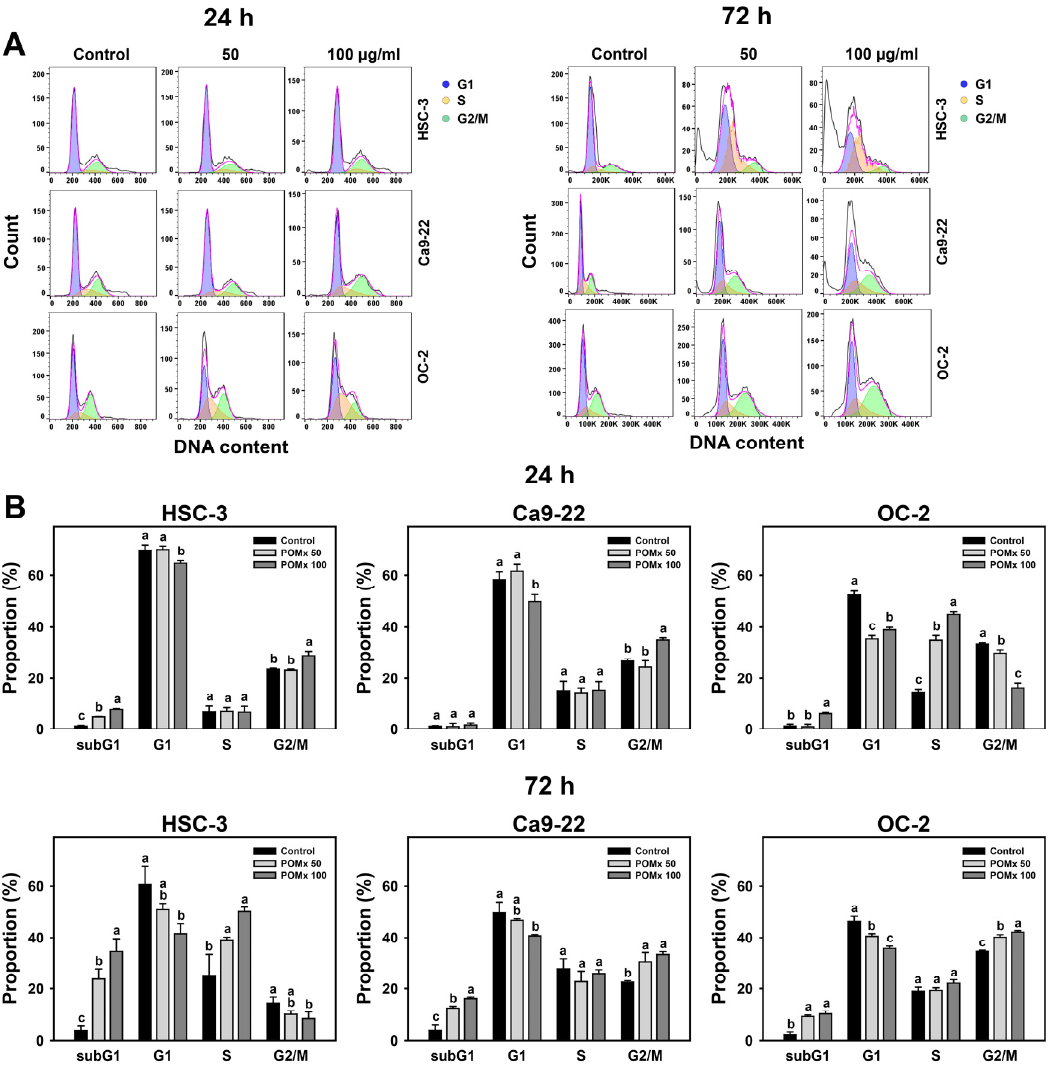
Figure 3. Cell cycle phase of oral cancer cells after POMx incubation. ( A ) Flow cytometry patterns. Cells (HSC-3, Ca9-22, and OC-2) were incubated with control, 50, and 100 µ g/mL of POMx (control, POMx 50, and POMx 100) for 24 and 72 h. ( B ) Statistics for ( A ). Treatments without overlapping low cases (a to c) represent significant differences for the same cell lines. p < 0.05. Data, mean ± SD ( n = 3).